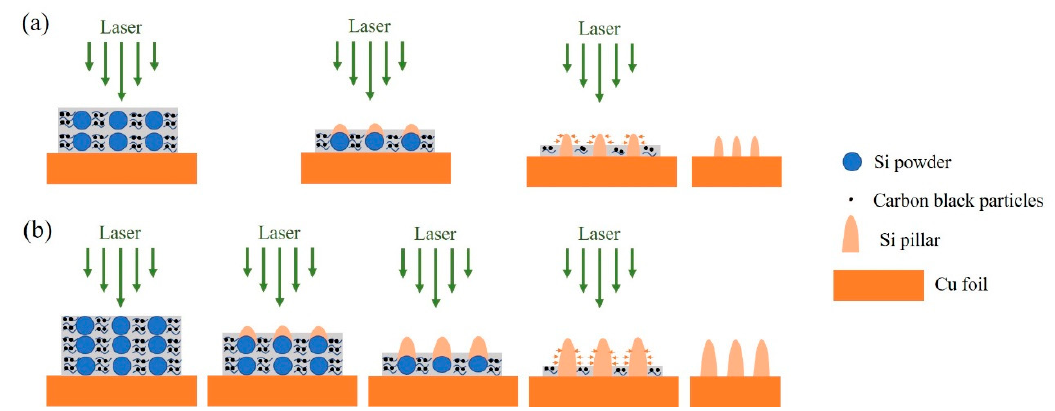
Figure 3. Schematic drawing of the laser irradiation process on ( a ) a thin slurry layer and ( b ) a thick slurry layer.